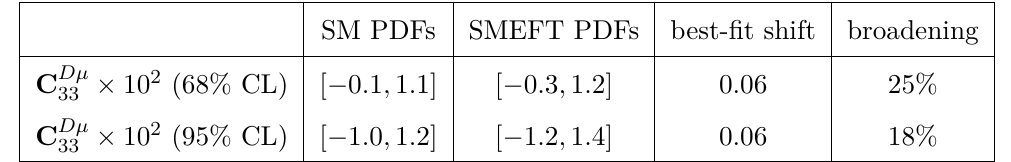
Table 8 . Same as table 6, now for the C Dµ